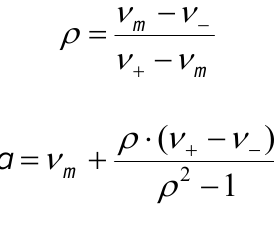
Figure 3. The log-normal